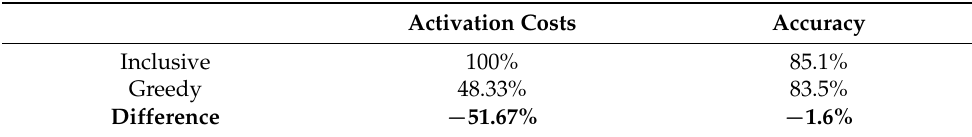
Table 1. Activation costs and accuracy